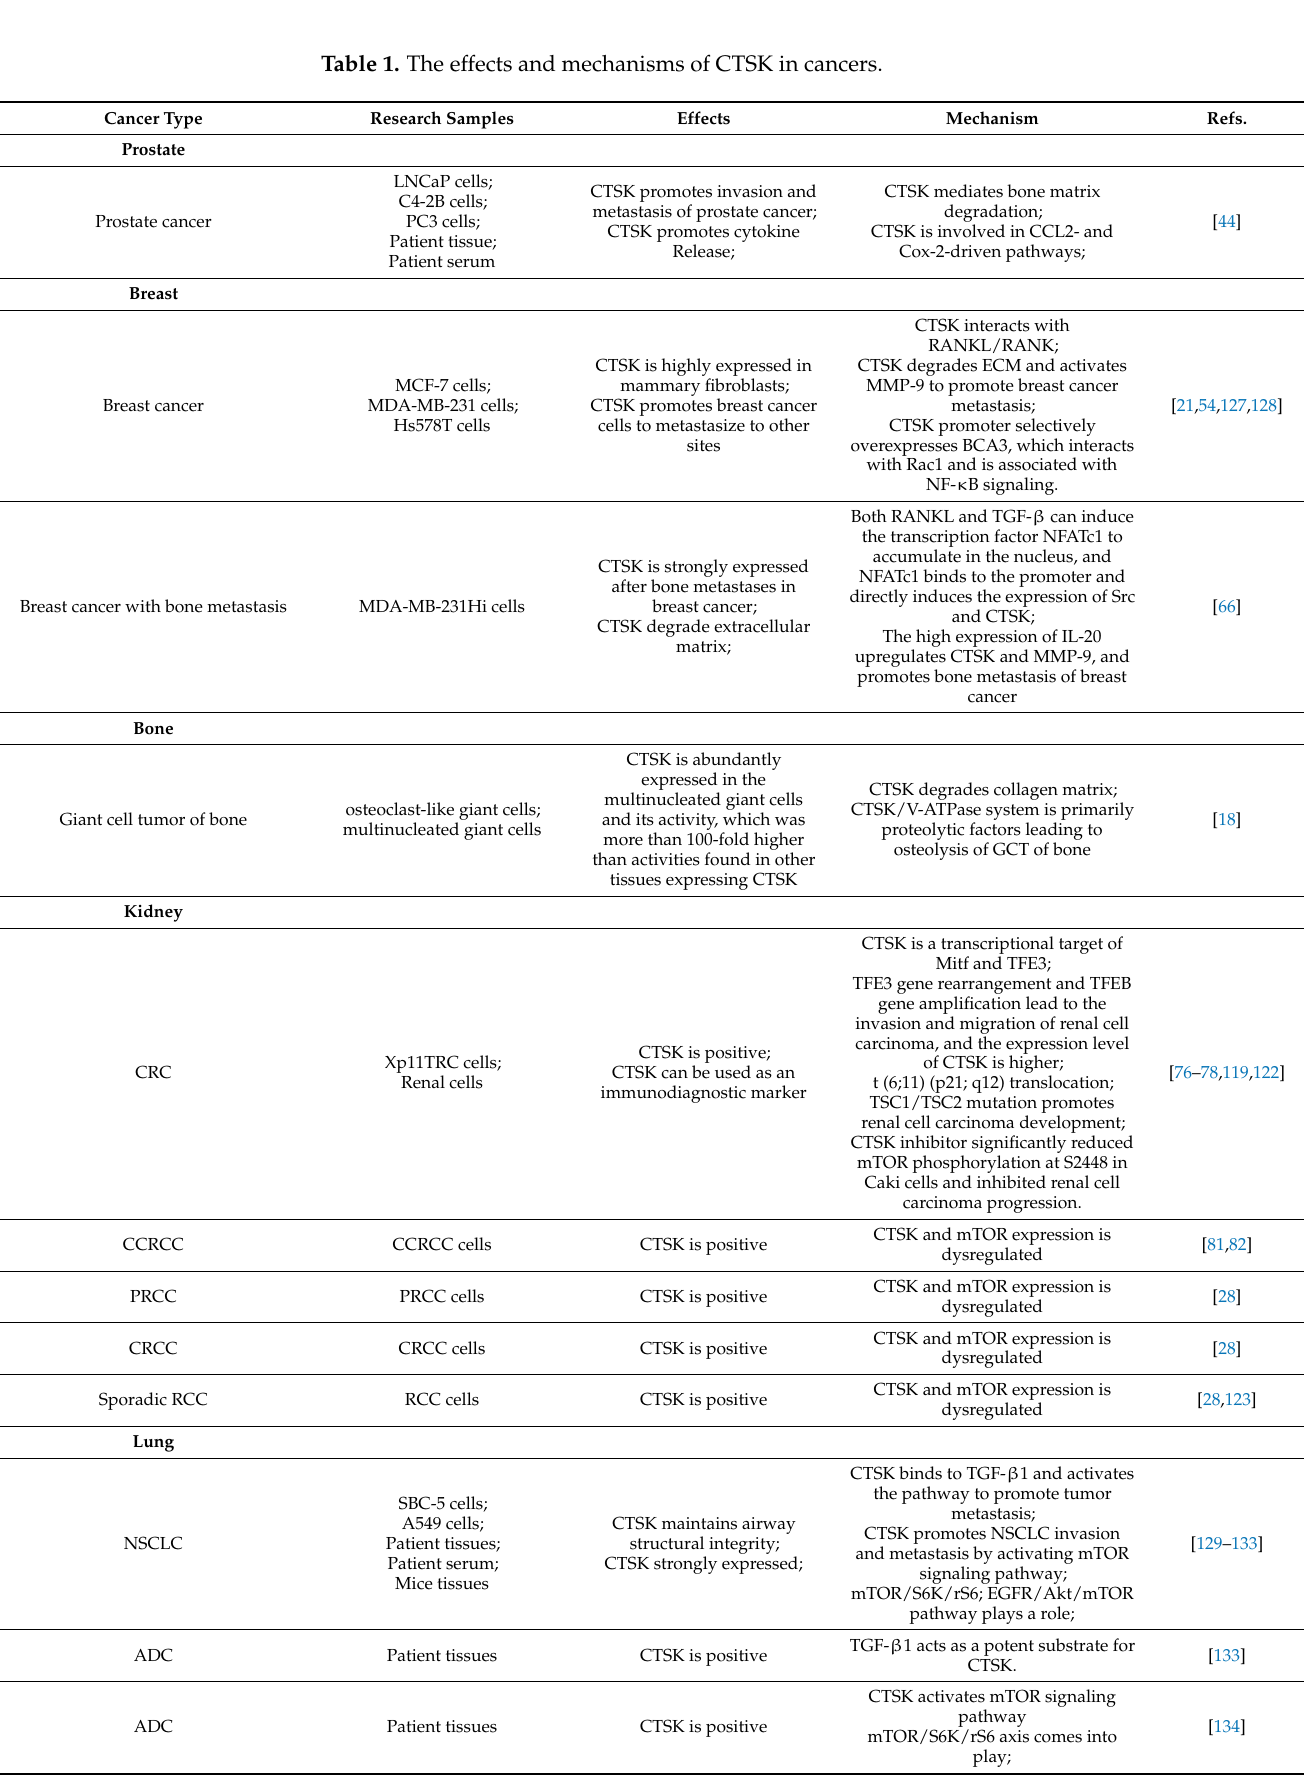
Table 1. The effects and mechanisms of CTSK in